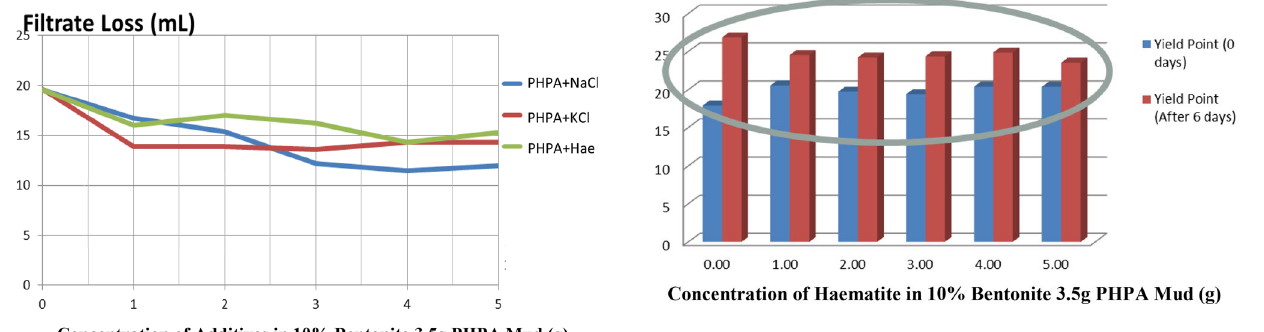
Fig. 23 Effect of haematite on yield point of PHPA-bentonite mud in accordance with